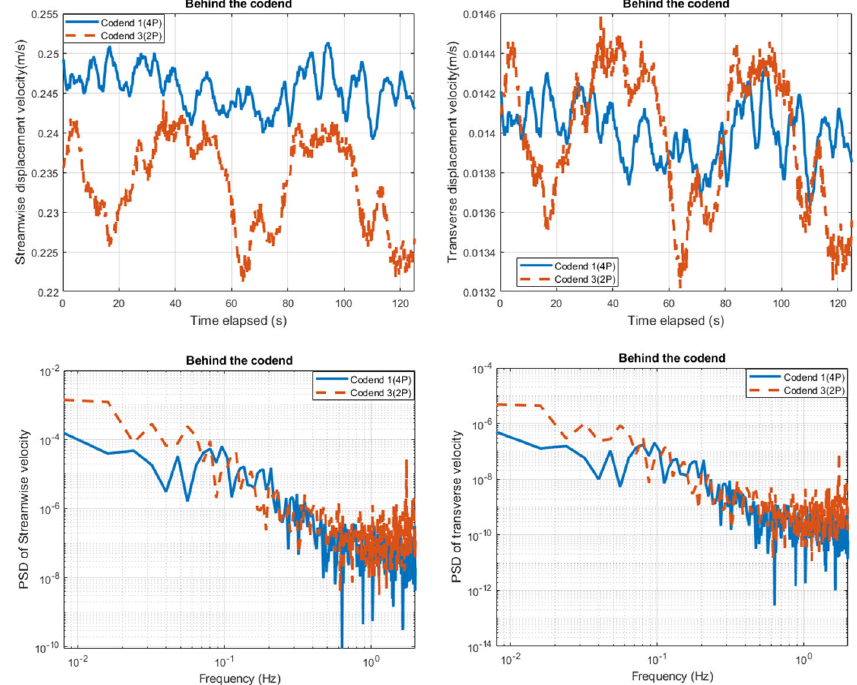
Figure 13. Time evolution of the streamwise velocity ( right ) and transverse velocity ( left ) linked to the normalized frequency spectrum (bottom in a log ‐ log scale) inside the different codends .